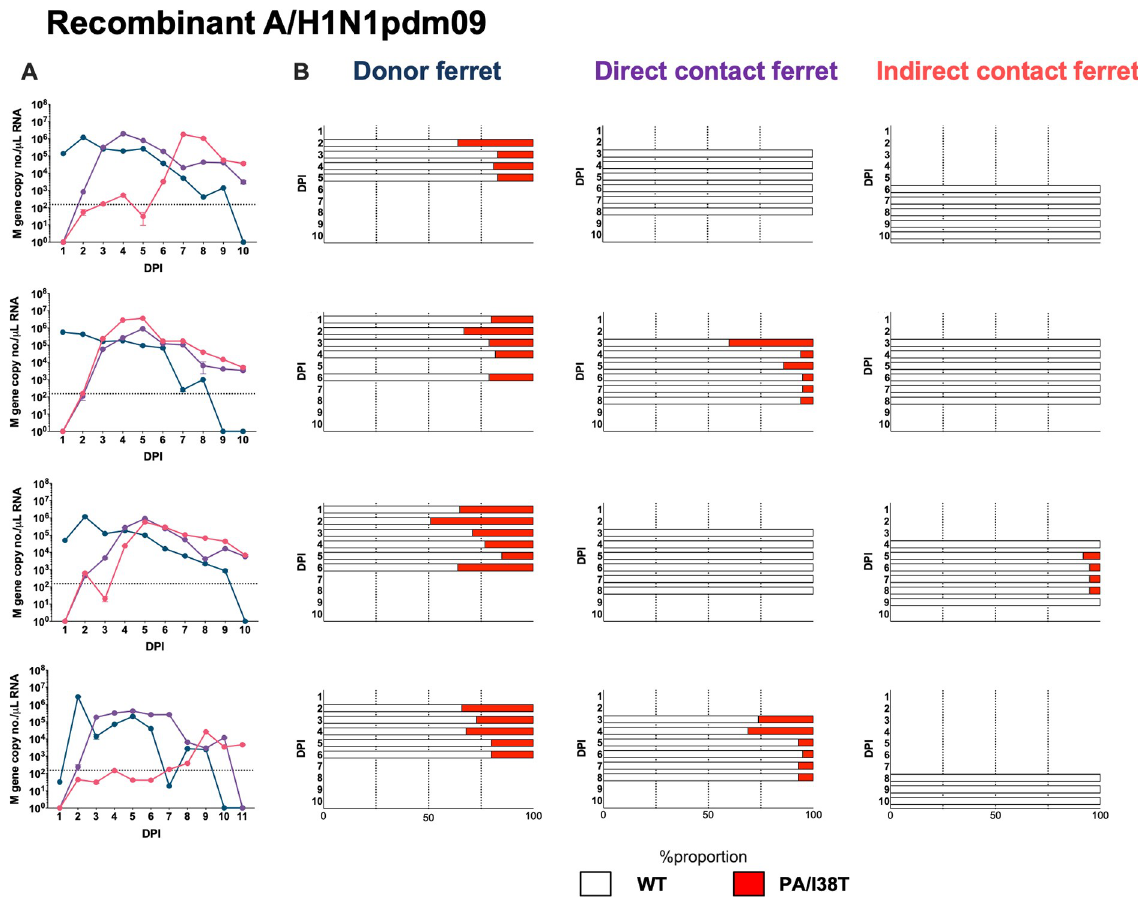
Fig 7. Change in WT/I38T virus proportion in nasal washes of donors compared to DC or IC recipients. Donor ferrets were infected (intranasal inoculation) with a recombinant A/H1N1pdm09 virus pair using 50:50 WT%: I38T% mixture based on infectious virus titer, at a total infectious dose of 10 4 PFU. Na ï ve recipient ferrets were exposed to infected donors at 1 DPI by cohousing in the same cage (direct contact), or by housing in an adjacent cage separated by a respiratory droplet-permeable interface (indirect contact) (1:1:1 ratio). The relative proportion of virus encoding WT PA (white bars) and PA/I38T (red bars) in each nasal wash sample was determined by next generation sequencing. DPI, days post inoculation; inoc, inoculation; PA, polymerase acid; WT, wild type.